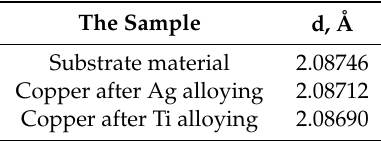
Figure 12. X-ray analysis of the substrate material before and after Ti and Ag alloying. Table 3. Interplanar distances of the laser-alloyed